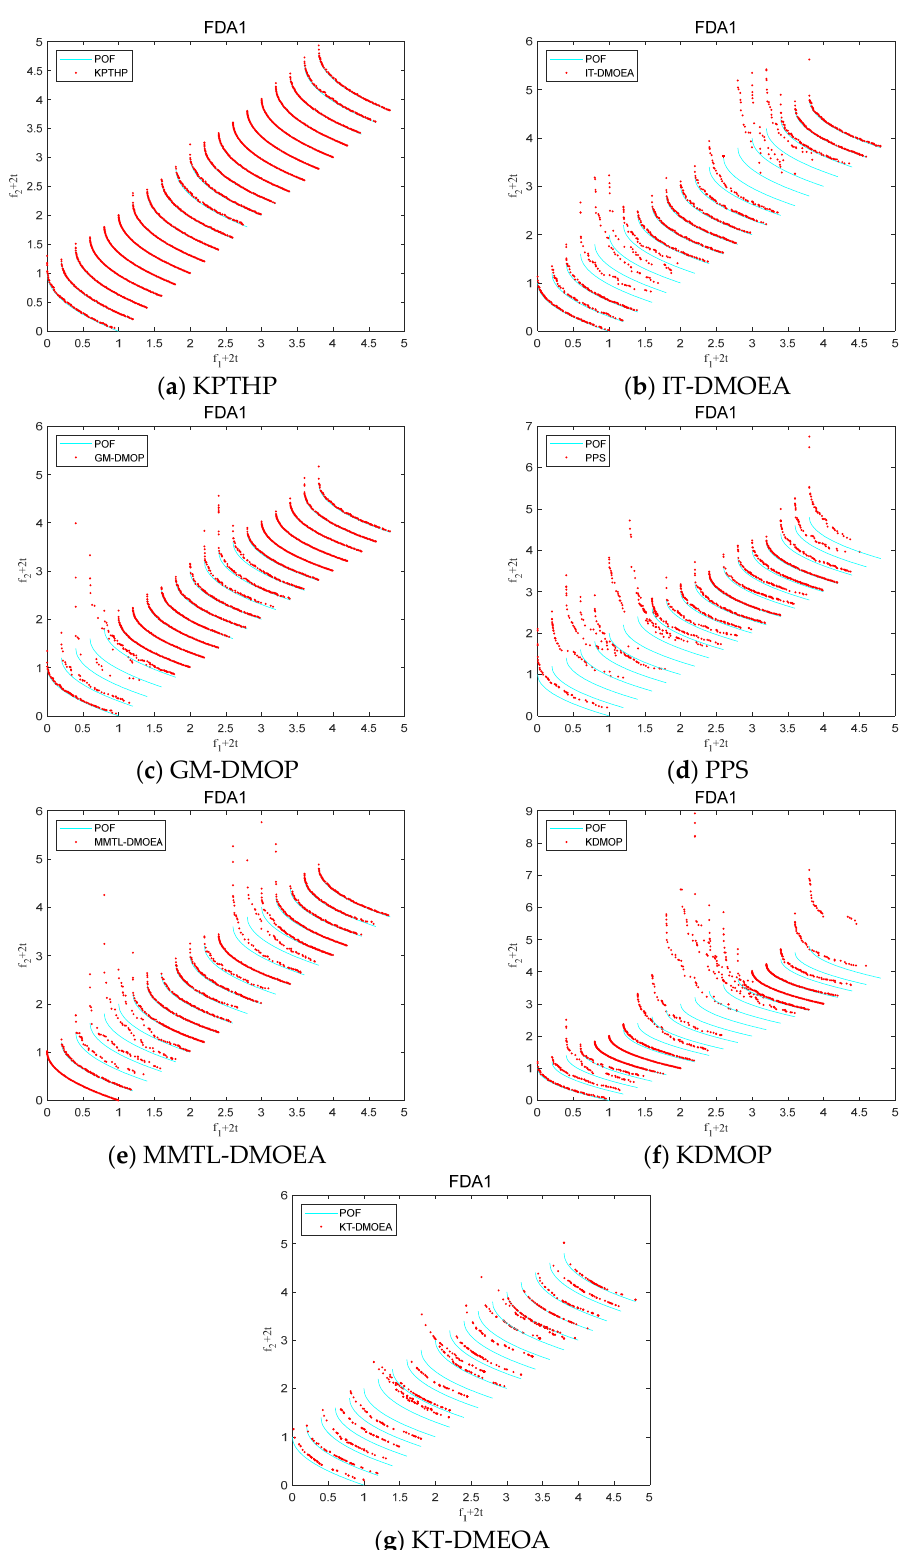
Figure 7. The POF of FDA1 obtained by the seven algorithms.